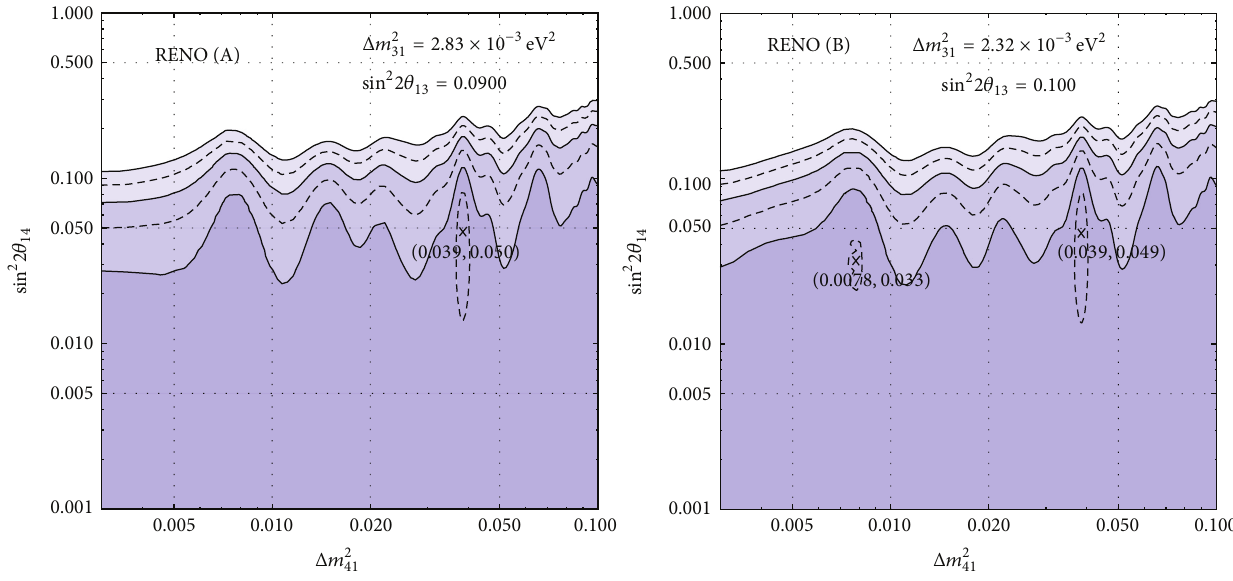
Figure 5: The 1𝜎, 2𝜎 , and 3𝜎 exclusion curves are drawn by solid lines. Apparently, a broad range of sin 2 2𝜃 14 apparently remains not excluded. Only Δ𝑚 2 41 > Δ𝑚 2 31 is considered and sin 2 2𝜃 14 > 0.2 is excluded at 3𝜎 CL. For (A) specified by Δ𝑚 2 31 = 2.83 × 10 −3 eV 2 , the minimum / dof = 0.48 is at (Δ𝑚 2 , sin 2 2𝜃 ) = (0.039 eV 2 , 0.050) , while, for (B) specified by Δ𝑚 2 𝜒 2 14 min 41 and 0.85 are located at (Δ𝑚 2 41 , sin 2 2𝜃 14 ) = (0.0078 eV 2 , 0.033) and (0.039 eV 2 ,0.049) ,